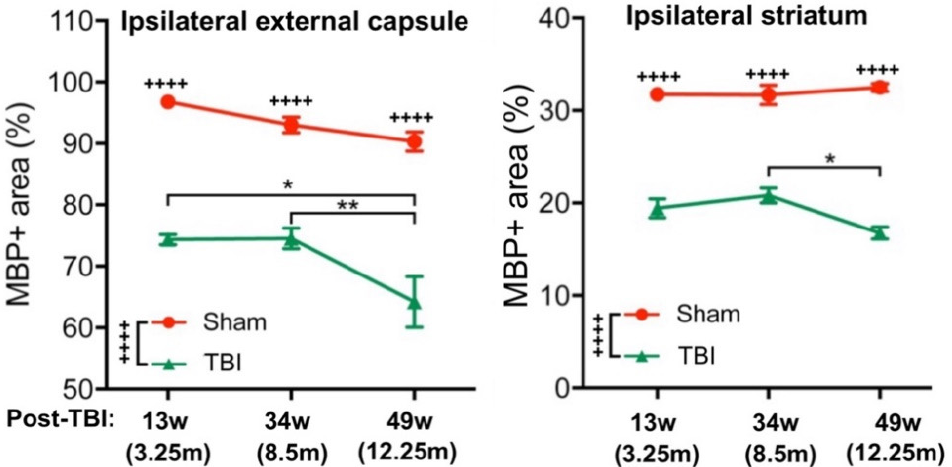
Figure 2. Persistent and progressive white matter demyelination in the ipsilateral external capsule and striatum 13, 34, and 49 weeks after TBI (i.e., at 1 day, 21 weeks, and 36 weeks post-treatment, or 3.25, 8.5, and 12.25 months after TBI). MBP + area: immunopositive area by immunostaining of myelin basic protein (MBP). Two-way ANOVA followed by Tukey post hoc test . Time point difference: * p < 0.05, ** p < 0.01; Sham vs. TBI: ++++ p < 0.0001.